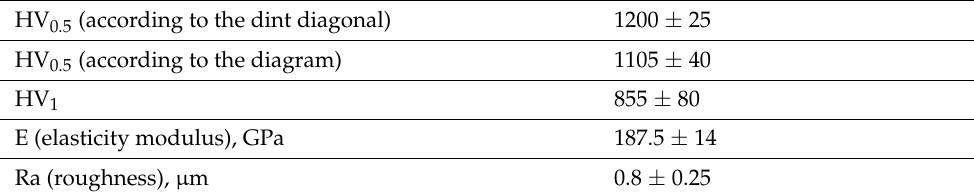
Table 9. Physical and mechanical parameters of the Cr 2 O 3 coating.